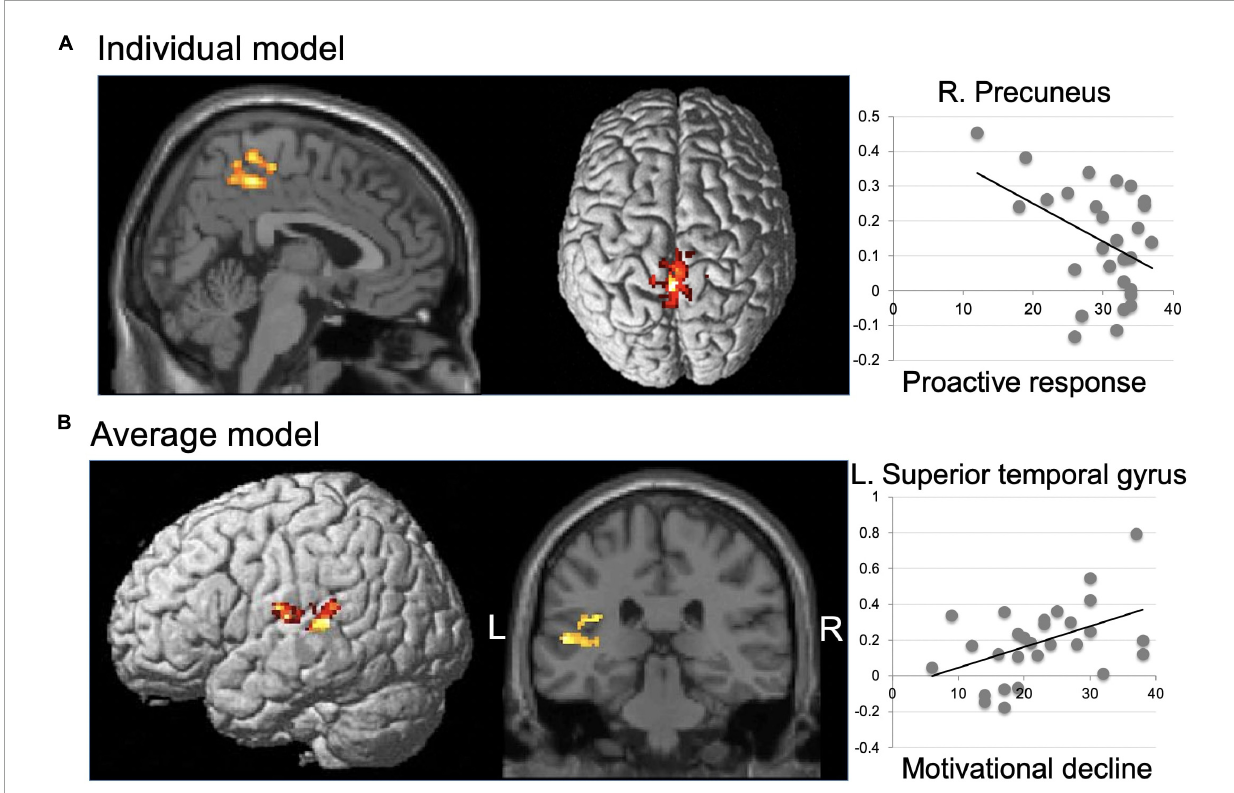
FIGURE2 Discomfort-related activation and the effect of the MTASQ score (first approach). Left panels, significant activation in the individual model (A) and the average model (B) are superimposed on the standard SPM12 anatomical brain. Right panel, estimate ( β ) of discomfort-related activation (vertical axis) of each individual plotted against the significantly associated MTASQ score (horizontal axis); that is, the proactive response for the individual model (A) and motivational decline for the average model (B) ; regression line is given for each plot. R, right; L,